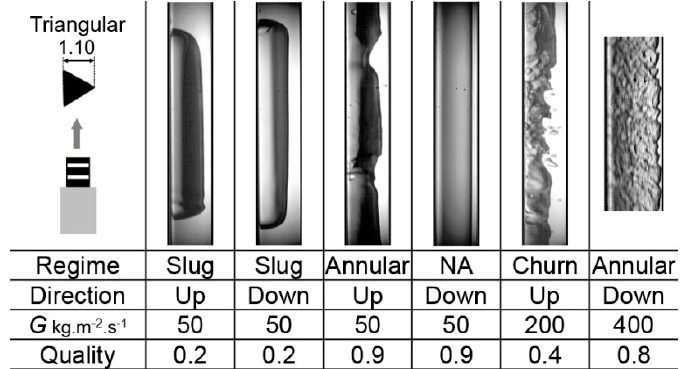
Figure 12. Triangular channel visualization with pylex glass [14].